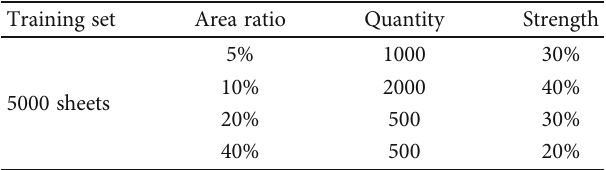
Table 1: Training